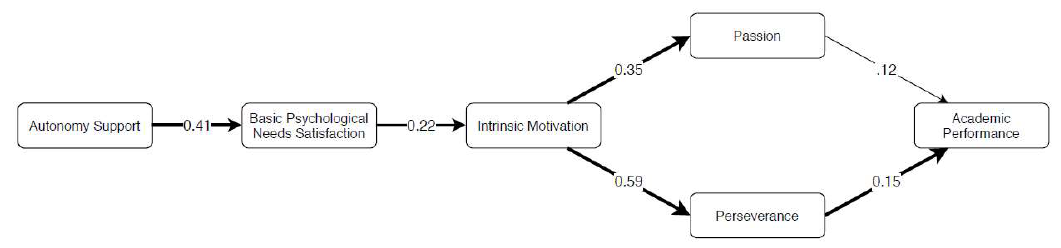
Figure 2. Standardized coe ffi cients are presented; thick lines = significant at p ≤ 0.05. Figure 2. standardized coefficients are presented; thick lines = significant at p ≤ 0.05. Table 2. Path estimates.